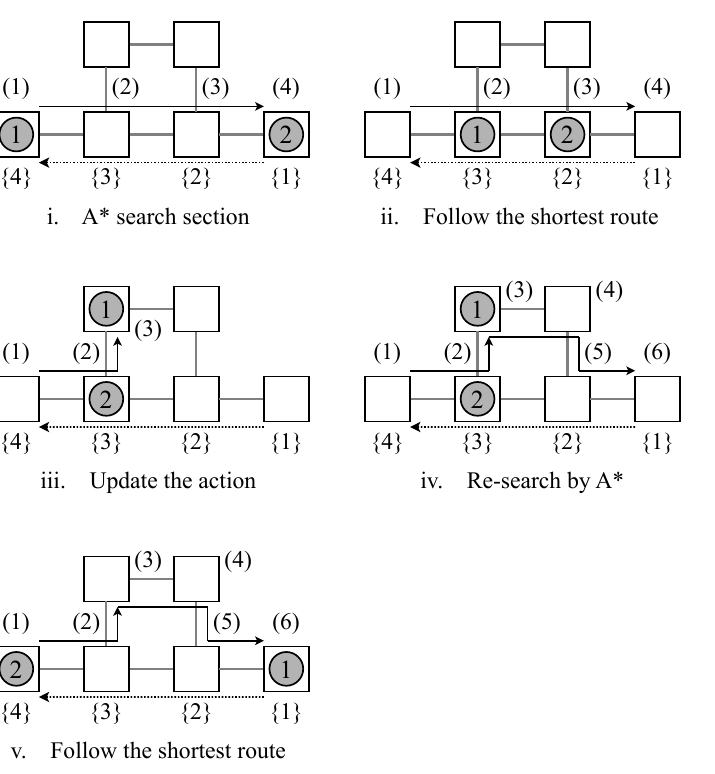
Figure 9. Routing result for two AGVs derived by the proposed method at each iteration. ( 1 ) , ( 2 ) , · · · , ( t ) indicates the route plan pf AGV1, and 1,2, · · · , t indicates the route plan pf